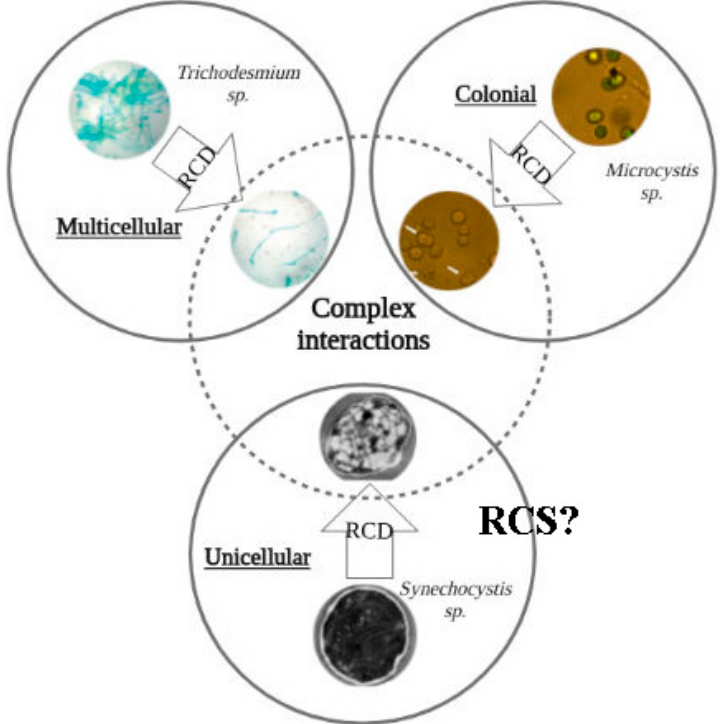
Figure 1. Regulated cell death (RCD) models in cyanobacteria. Regulated cell death (RCD) has extensively been studied in a few biological models. It includes multicellular (filamentous) cyanobac- teria, such as Trichodesmium spp. ( top left ). RCD was also documented in colonial strains and in some unicellular organisms, which was recently suggested could reverse multicellularity ( Microcystis spp.— top right , Synechocystis spp.— bottom ).